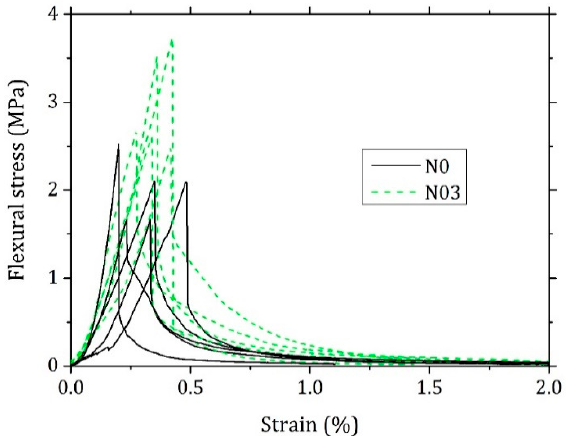
Figure 12. Representative flexural stress–strain curves from the three-point-bending test for samples